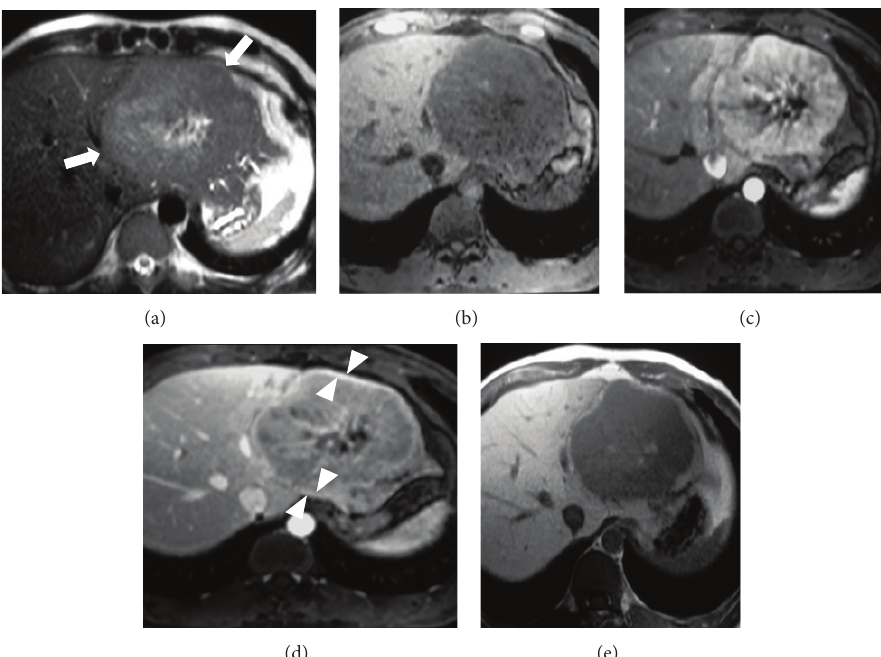
Figure 10: Fibrolamellar HCC. (a) Axial T2w image. In left lobe slightly well delineated mass (arrows) with heterogeneous central area. (b–d) In dynamic evaluation after Gd-BOPTA the lesion appears markedly heterogeneous hypervascular in arterial phase (c); it shows rapid and progressive wash out in portal phase. The central area is hypointense. Note complete thick pseudocapsule at the periphery (arrowhead). (e) In hepatobiliary phase image the lesion is hypointense; the central fibrotic component retains contrast